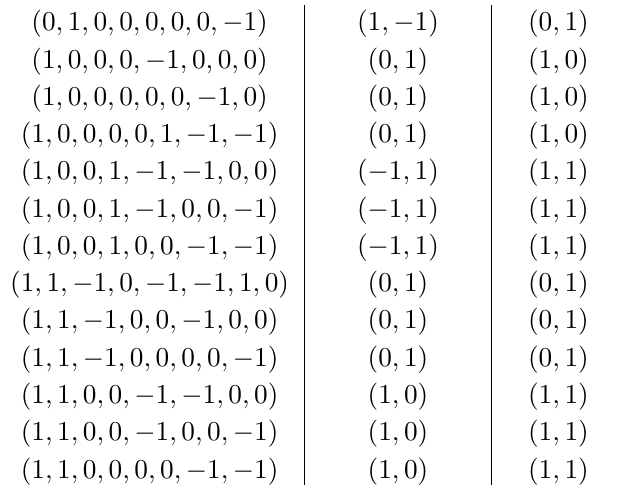
Table 8 : The 54 junctions near the point of enhancement IV charge of the state under the Cartan U(1) 2 of SU(3) . a ( J ) is computed with respect to the first four 7-branes which are the gauge